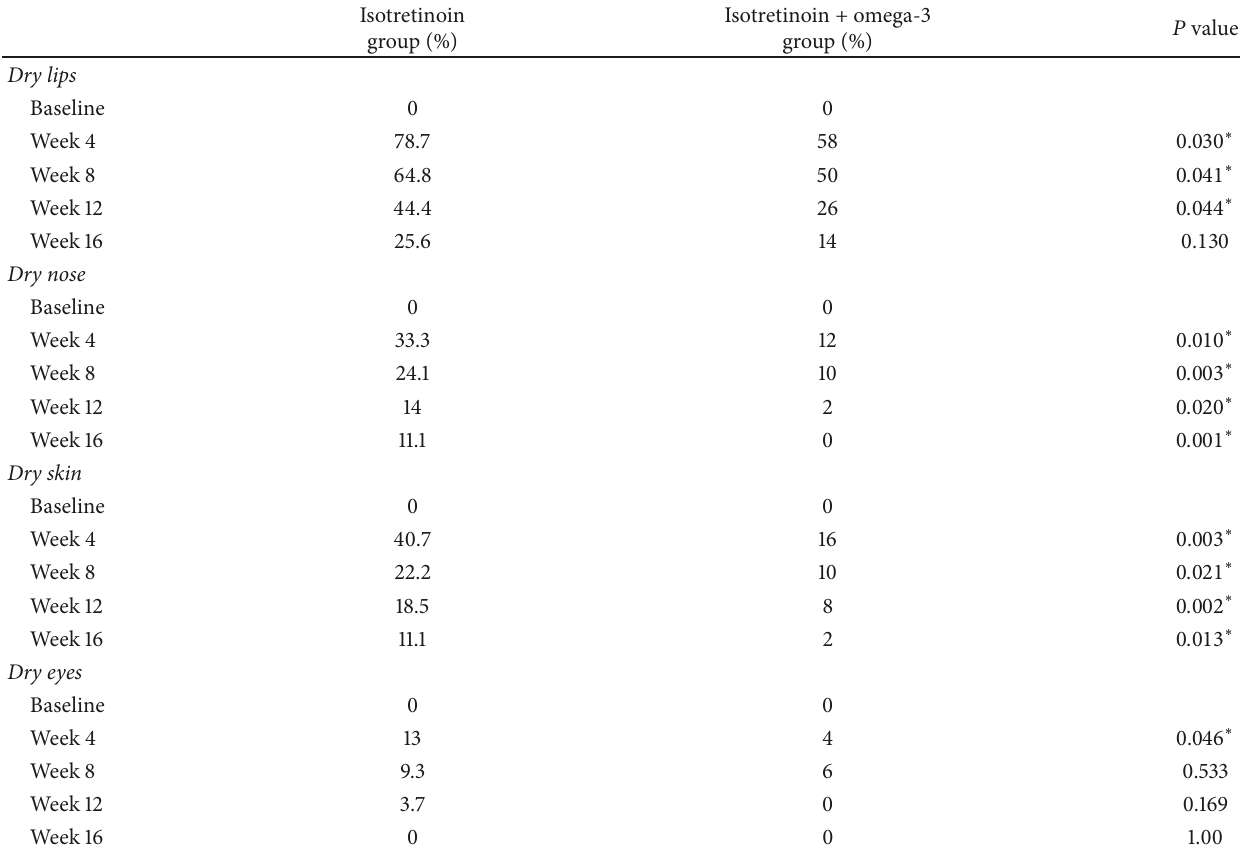
Table 2: Comparison of the frequency of mucocutaneous side effects of isotretinoin between case and control groups.